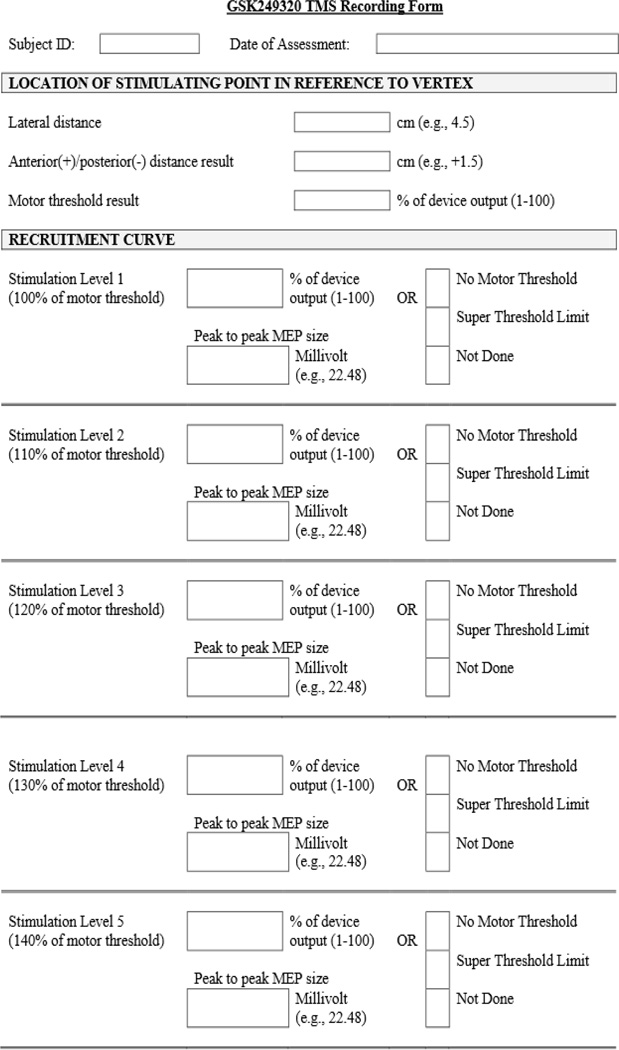
TMS recording form.